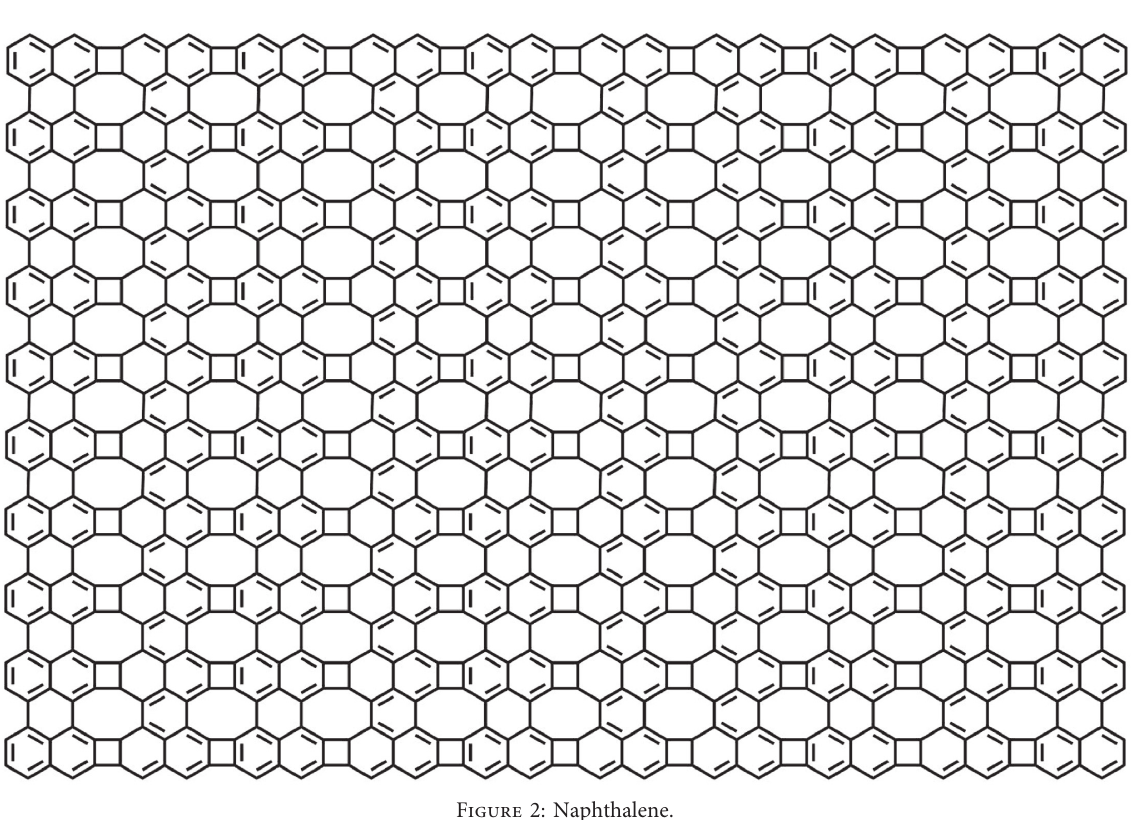
C nanosheet. 4 8